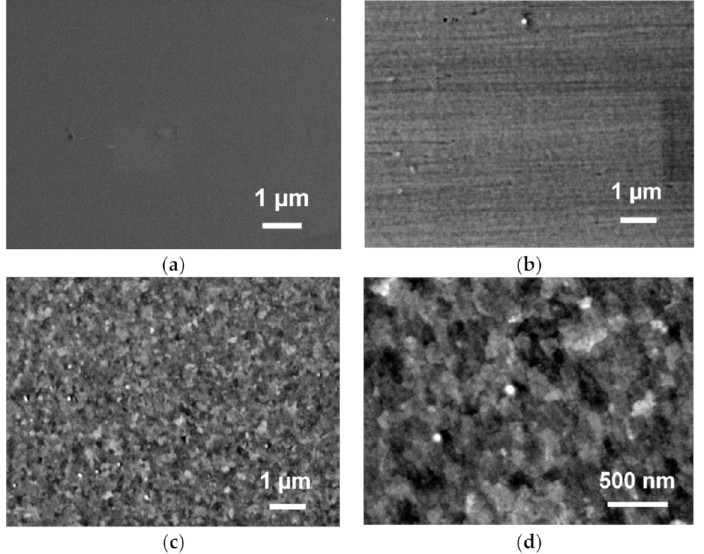
Figure 2. FE-SEM images of semiconductor layers in TiO 2 P ( a ), TiO 2 S ( b ) and TiO 2 H ( c , d ). Magnifi- cation is × 10 K ( a – c ) and × 30 K ( d ), with corresponding length bars of 1 µ m and 500